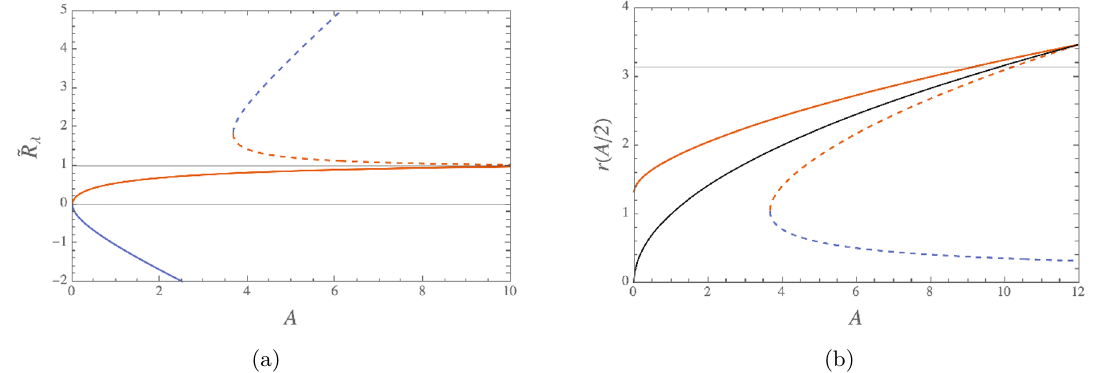
Figure 1. (a) Deformation of the radius e R ± , λ = − 2 τ . (b) Maximum distribution r ( A/ 2) of the λ fluid on the unit circle. The 3-rd order phase transition takes place when r ( A/ 2) = π . Solid line — τ > 0 ; dashed — τ < 0 . Red line — perturbative branch; blue line — non-perturbative